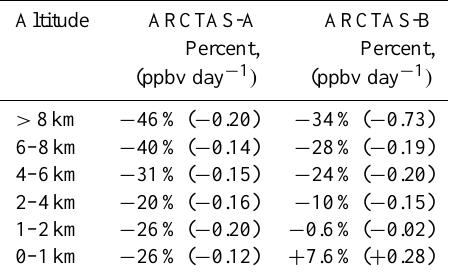
Table 7. Changes in O 3 gross formation when using observed HO 2 . Table A1. 1 σ uncertainties for selected input constraints on 60 s time